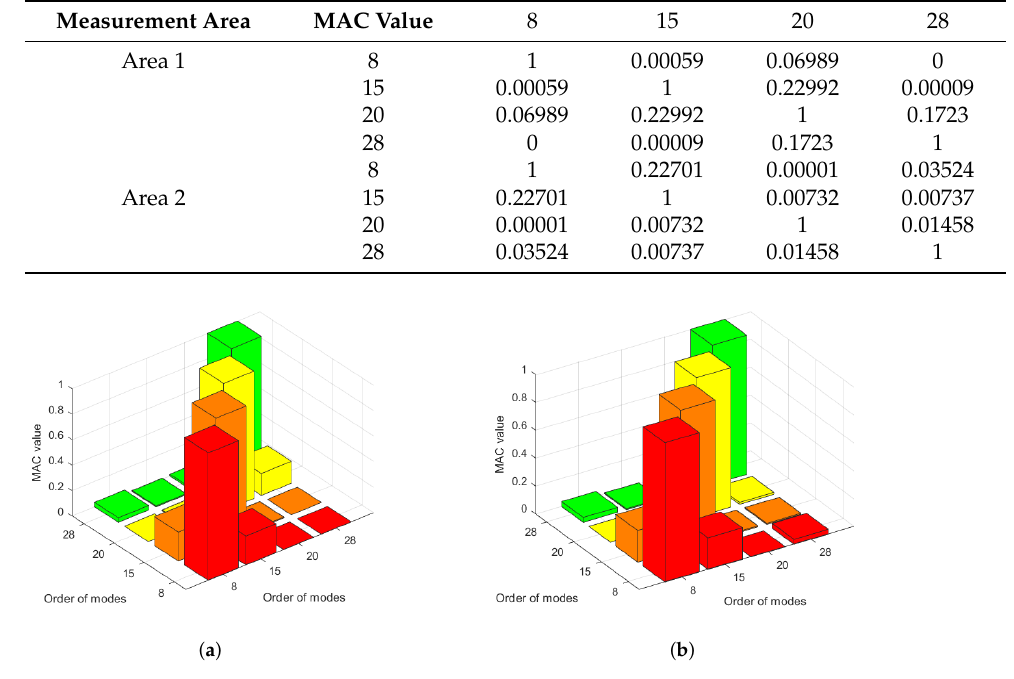
Figure 8. MAC of main vertical mode ( a ) Area 1; ( b ) Area 2.